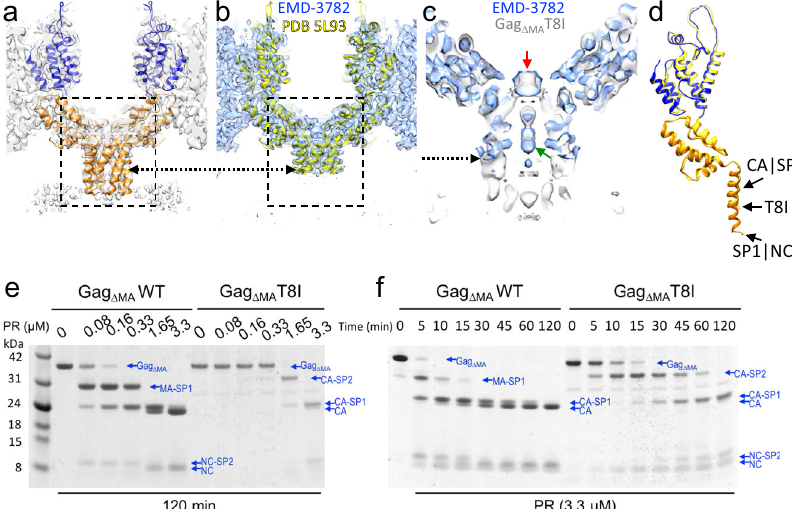
Fig. 3 T8I mutation stabilizes the six-helix bundle and impairs proteolytic processing of cleavage sites fl anking SP1. a , b Comparison of the CA-SP1 hexamer in Gag Δ MA T8I ( a ) and Gag Δ MA WT (EMD-3782) ( b ), shown in a side-view. The density map is overlaid with the respective atomic model. The dashed arrows points to the position of the eighth aminoacid in SP1 in both maps. c An enlarged view of density overlay from the dashed box region in ( a , b ). The Gag Δ MA T8I density is in grey and the Gag Δ MA WT density is in blue. The red arrow points to the same central density shown in Fig. 2d. The green arrow points to BVM density in EMD-3782. d Overlay of the re fi ned atomic models from Gag Δ MA T8I and Gag Δ MA WT (PDB 5L93). Arrow points to location of T8I mutation and CA|SP1 and SP1|NC cleavage sites. e , f In vitro protease cleavage assays. Gag Δ MA WT and Gag Δ MA T8I assemblies were incubated with recombinant HIV-1 PR at the indicated concentration ( e ) and for the indicated period of time ( f ), separated in an SDS-PAGE and stained with Coomassie Blue. For processing intermediates, bands are labelled by listing the fi rst and last